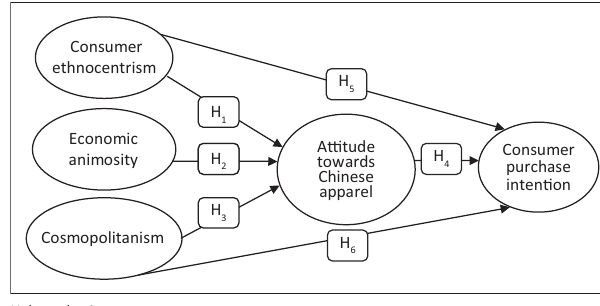
FIGURE 2: Alternative research model 2.